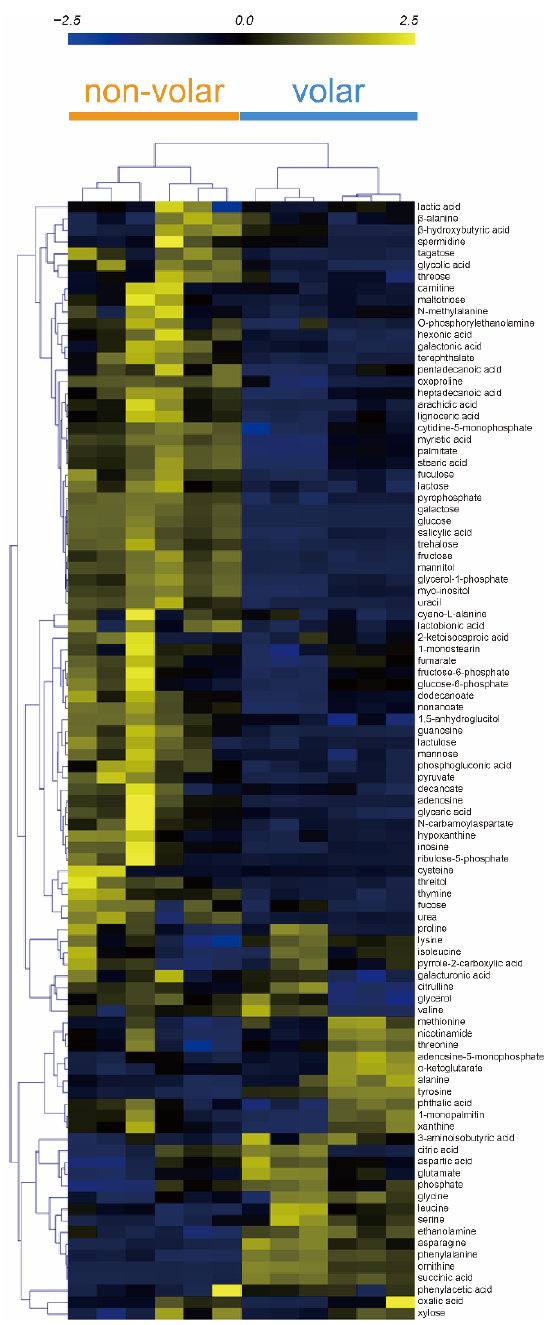
Figure 2. Hierarchical clustering analysis (HCA) of 96 metabolites from volar and non-volar skin tissue. Clustering similarity was evaluated based on the Pearson correlation coefficient and average linkage method. Each vertical column represents one of the six samples of volar skin and non-volar skin whereas each horizontal row represents a different